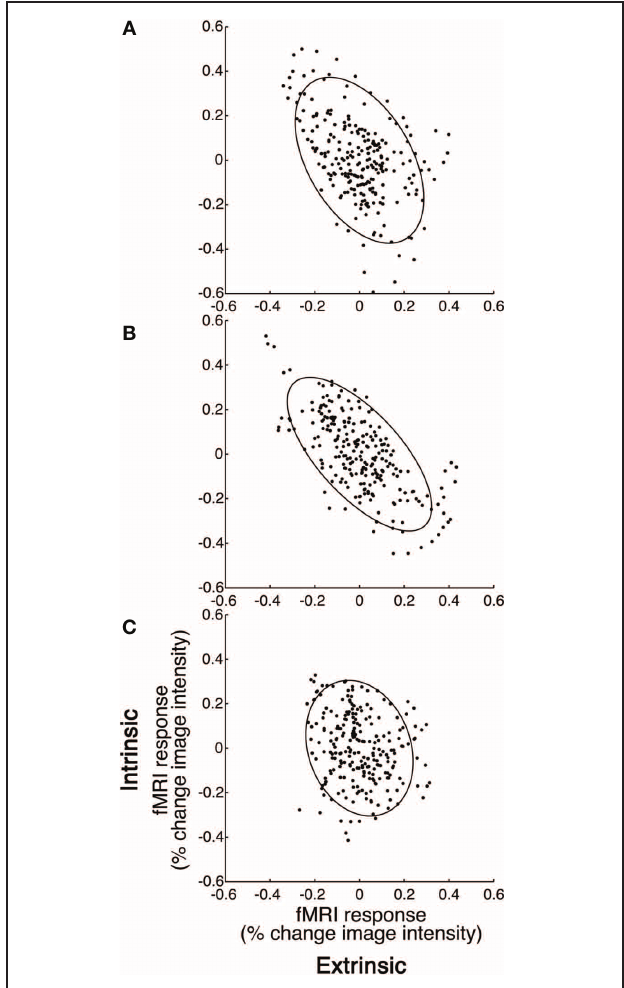
FIGURE 3 | Inter-area correlation. (A) Fixation. (B) Focused attention (FA). (C) Non-dual awareness (NDA). Abscissa, activity in extrinsic system. Ordinate, intrinsic system. Each data point represents the fMRI responses at one time point, averaged across all voxels in each of the two systems, for a typical example participant. Ellipse, level contour of best-fit bivariate normal distribution. The leftward tilt of each ellipse indicates the degree of anti-correlation, although statistics were computed using randomization tests so as not to assume that the fMRI responses were normally distributed and statistically independent at successive time points (see Methods for